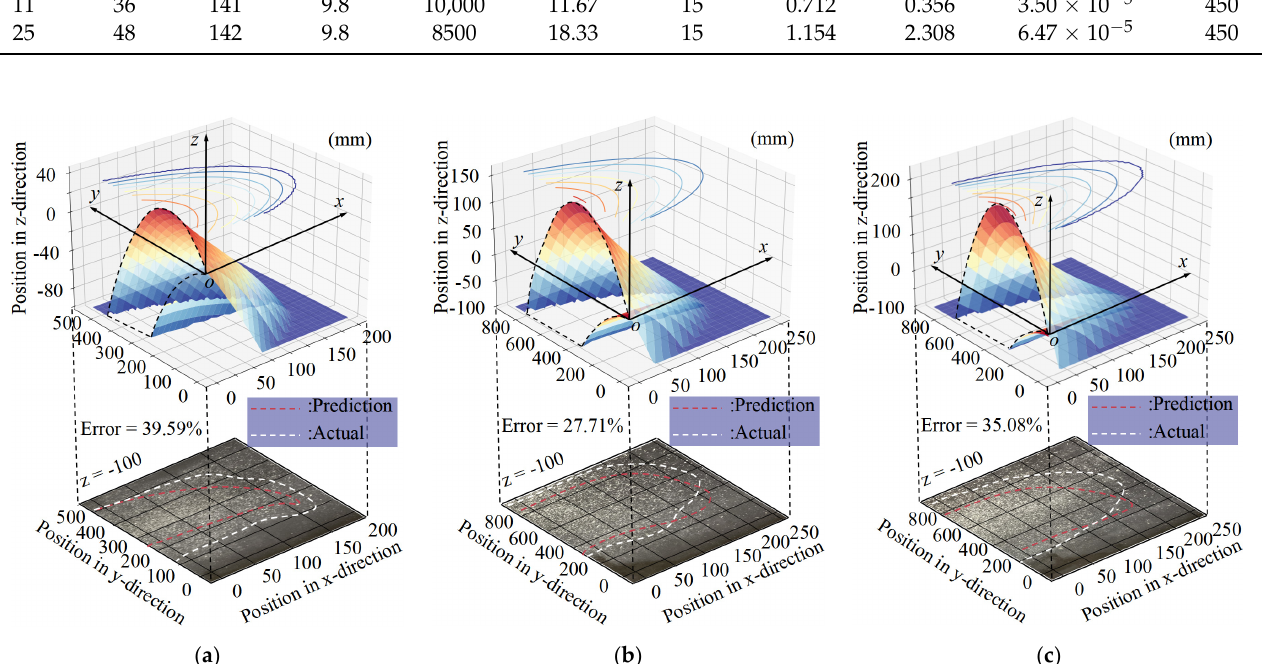
Figure 10. The results of solving the f(x,y) model with different milling parameters. ( a ) The surface model f(x,y) was implemented and the actual chip scattering area was calculated using data from test No. 1. The error of area is 39.59%. ( b ) The surface model f(x,y) was implemented and the actual chip scattering area was calculated using data from test No. 11. The error of area is 27.71%. ( c ) The surface model f(x,y) was implemented and the actual chip scattering area was calculated using data from test No. 25. The error of area is 35.08%.